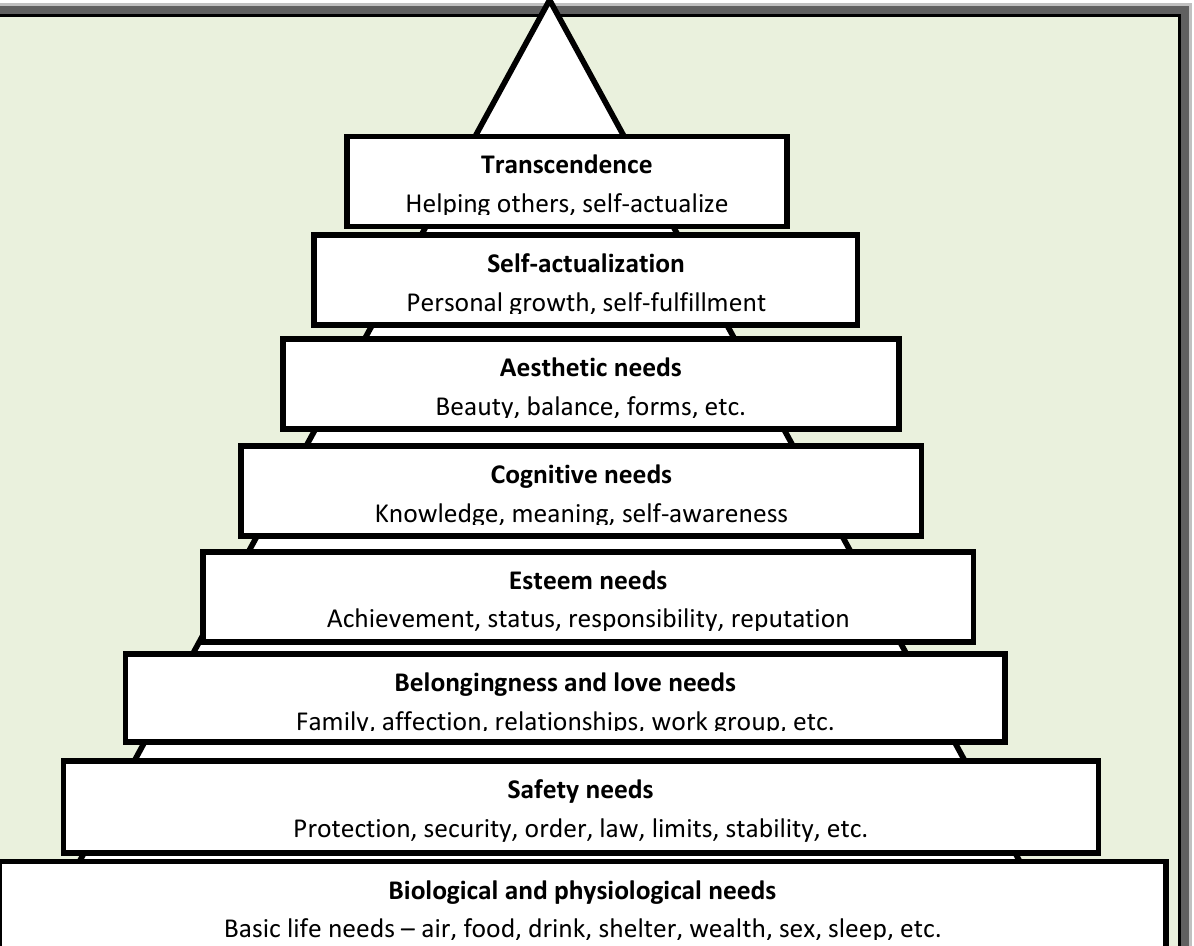
Figure 2.2 Maslow’s Hierarchy of Needs (1990s Eight-Stage Model) ( Tay & Diener , 2011